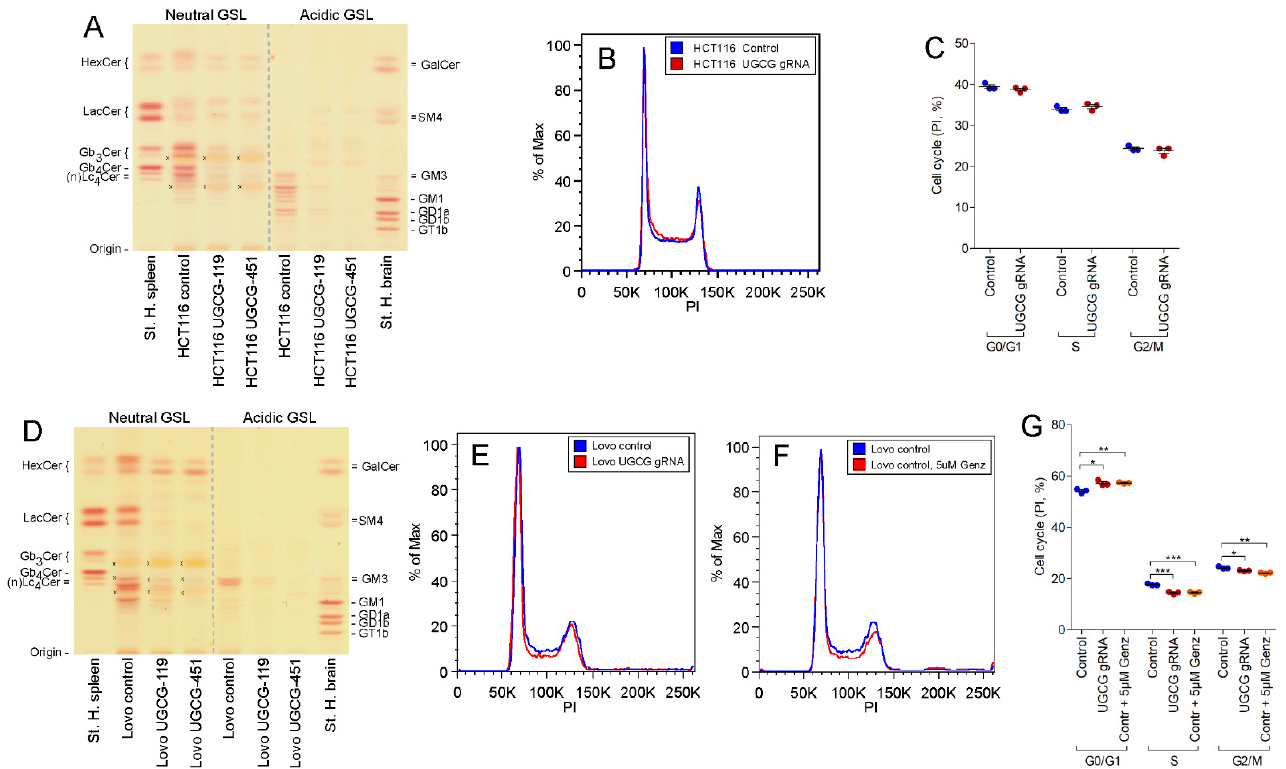
Figure 4. TLC and cell cycle determination of UGCG -gRNA treated HCT116- and Lovo cells. ( A , D ) An almost complete depletion of neutral and acidic GSLs was achieved in HCT116- ( A ) and Lovo cells ( D ) by UGCG -guide-RNA (gRNA); x, no GSL-positive band; running solvent for neutral- and acidic GSLs was CHCl 3 /CH 3 OH, 0.2% CaCl 2 , 60:35:8 ( v / v ). ( B , C , quantification) UGCG -gRNA treated HCT116 cells did not show an arrest of the cell cycle, similar as HCT116 cells treated with low doses of Genz (Figure 2). ( E , F , G , quantification) Genetic depletion using UGCG -gRNA-application ( E ) and treatment of Lovo cells with 5 µM Genz ( F ) resulted in an arrest of the cell cycle, whereas the response in Genz-treated cells was slightly more pronounced; significances are *, p ≤ 0.05; **, p < 0.01; ***, p < 0.001.